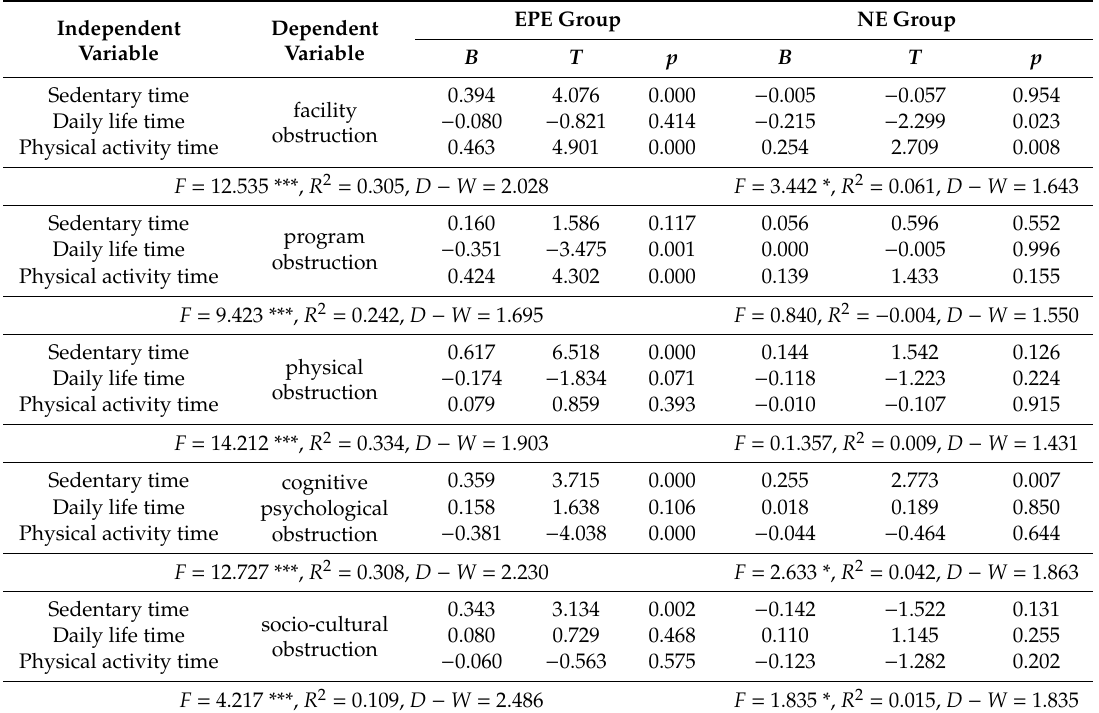
Table 1. Results of the multiple regression analysis of the physical activity levels and obstruction factors based on the physical activity participation experience. EPE group: exercise participation experience; NE group: non-experience.